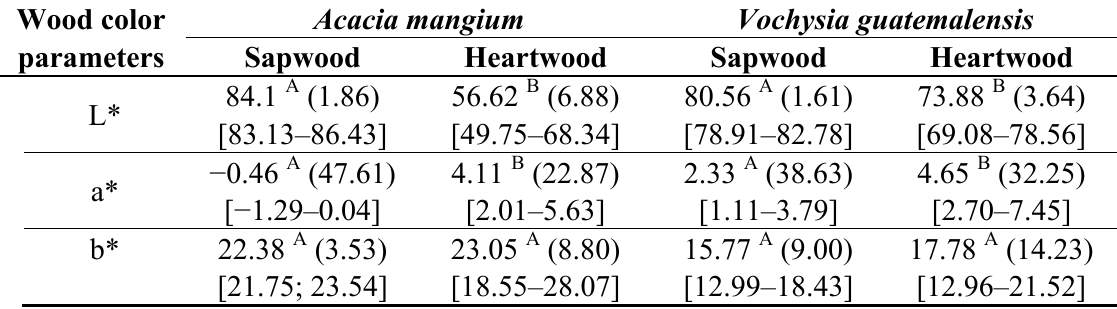
Table 1. Color parameters of Acacia mangium and Vochysia guatemalensis using the CIELab